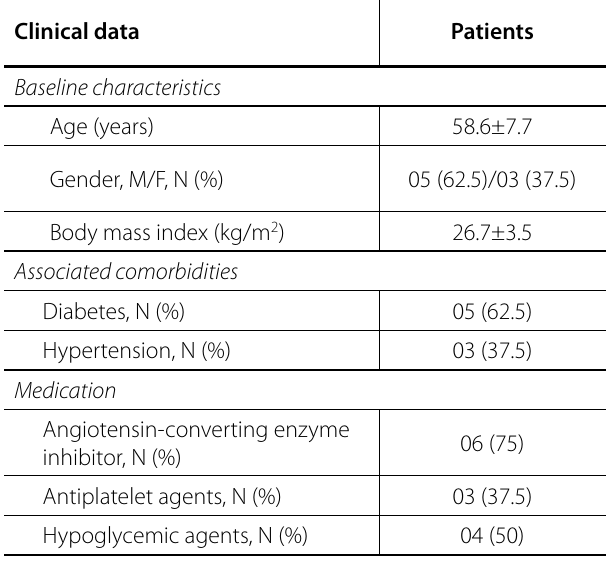
Table 1 . Study patients’ clinical profile